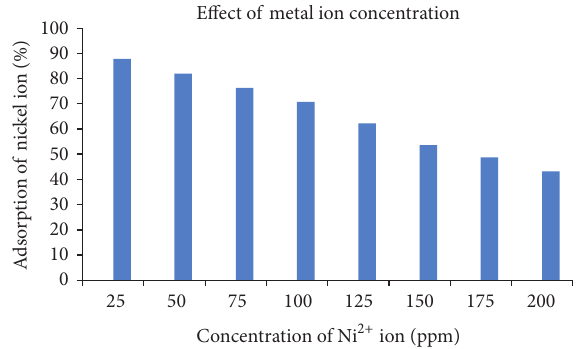
ions on ZLRC. 2+ F 9: Effect of other ions on the adsorption of Ni